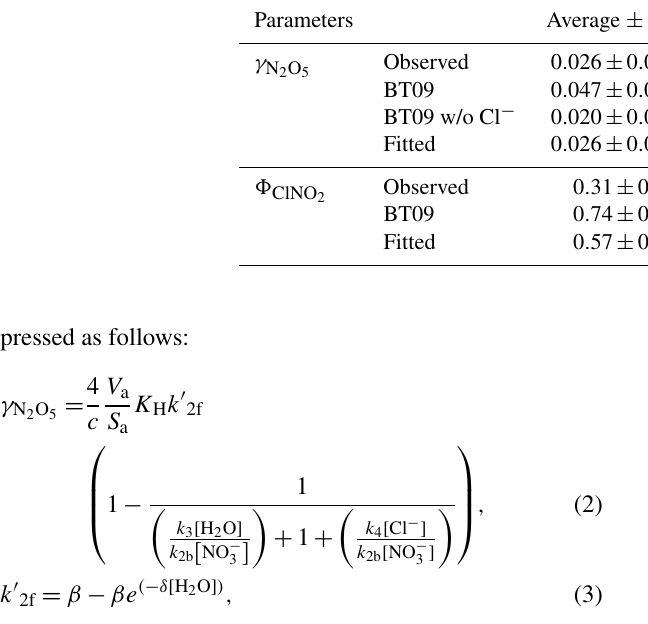
Table 1. Statistical summary and comparison of the observed parameters (N 2 O 5 uptake coefficient, γ N values predicted from different